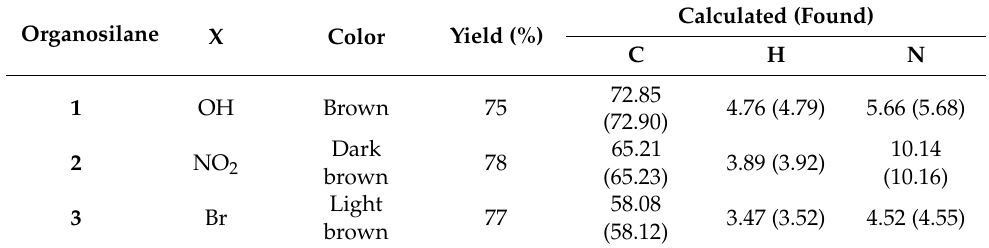
Table 1. Physical properties for 1 − 3 organosilanes.